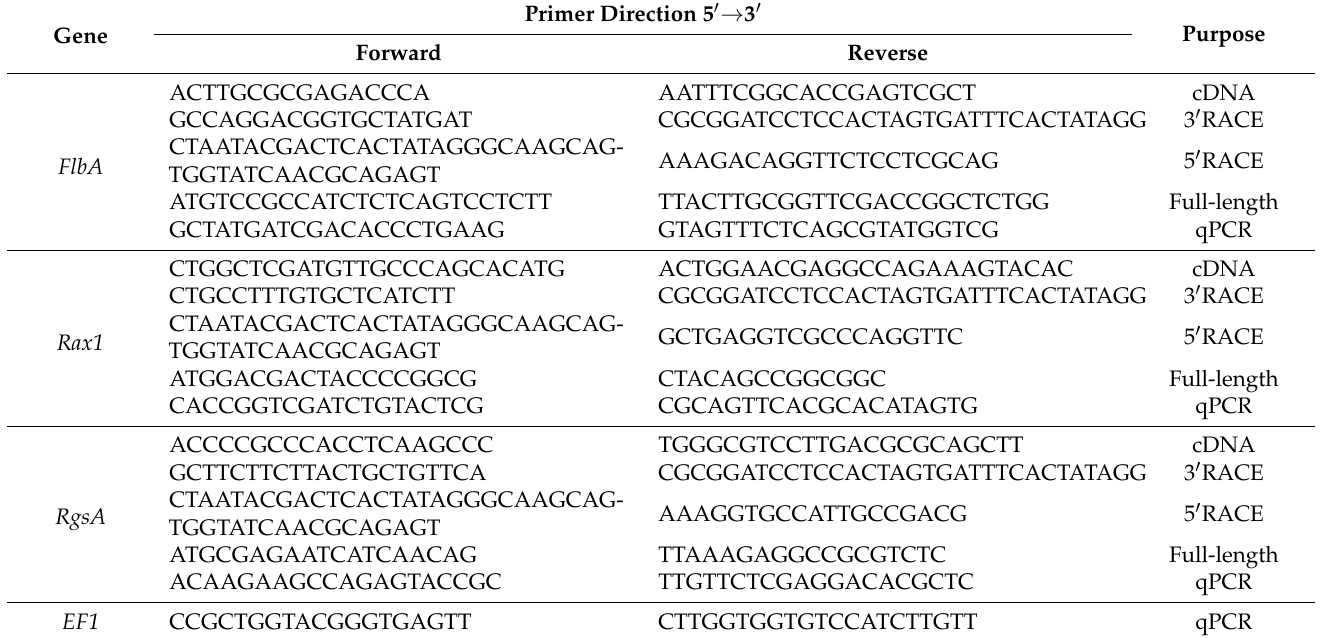
Table 2. Primer sequences used in the